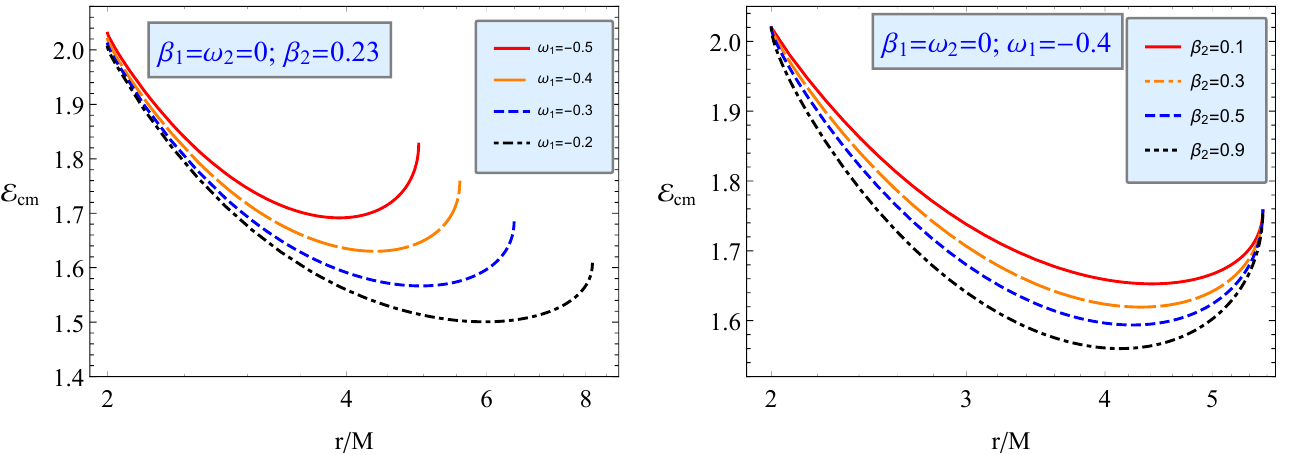
Figure 12. The same as Figure 9 but for the collisions of negatively charged particles with non-dipole- positive magnetized particles with no